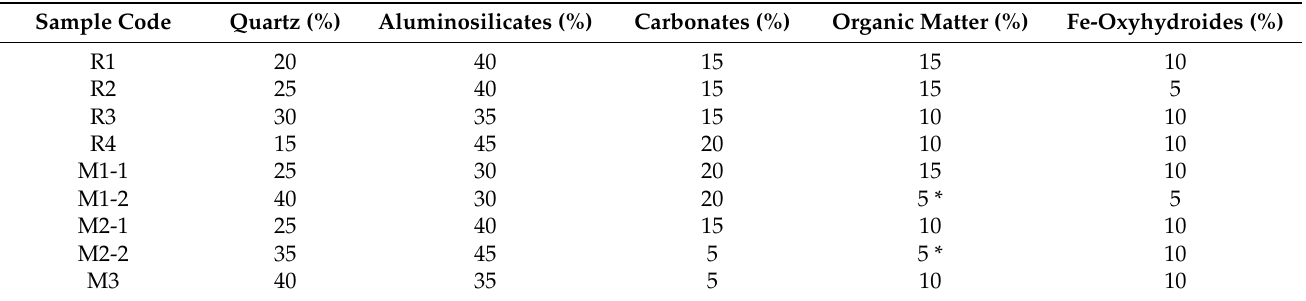
Table 3. Estimated percentage content of main particle groups in rainwater and snowmelt water samples. The content of other particles is less than 5% but varies between samples and was not included in this